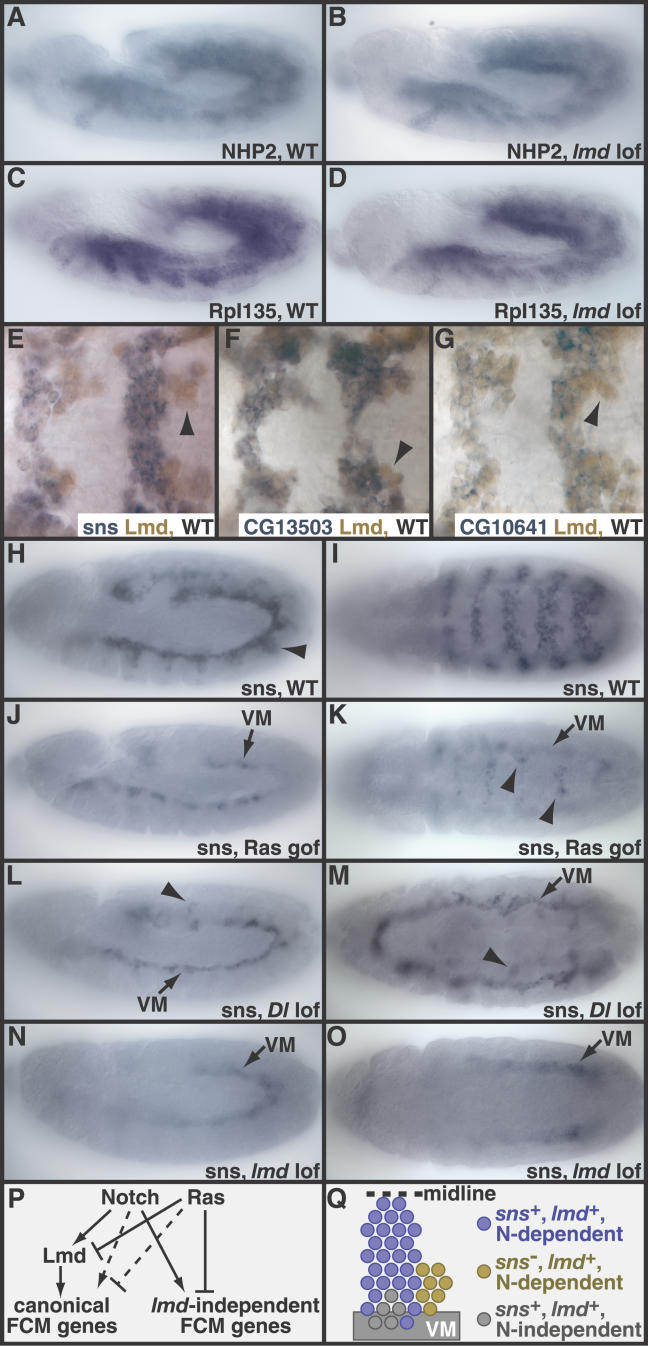
Heterogeneity in the Regulation of FCM Gene Expression(A–D) In situ hybridization of wild type and lmd mutant embryos with NHP2 (A and B) and RpI135 (C and D) gene probes shows that expression of these two FCM genes is independent of Lmd regulation.(E–G) Subset of ventral Lmd-expressing myoblasts (orange nuclei) without the expression of FCM markers such as sns, CG13503, and CG10641 (arrowheads in E, F, and G, respectively).(H–O) A subset of ventral myoblasts displays unexpected behavior. Wild-type expression of sns is observed in lateral (H) and ventral (I) somatic myoblasts (arrowhead in H). Lateral somatic myoblast expression is uniformly downregulated in Ras gof (J), Dl mutant (L), and lmd mutant (N) embryos, although visceral mesoderm (VM) expression is largely unchanged. A small ventral population of sns-expressing myoblasts remains in embryos with constitutive Ras activation (K, arrowheads) or loss of Dl (M), but expression in these cells is lost in lmd mutant embryos (O).(P) Expression of previously described (“canonical”) FCM-specific genes depends on Lmd, which is activated by Notch signaling and repressed by Ras signaling; a subset of FCM genes (A–D) are under the control of the Ras and Notch signaling pathways but do not require Lmd for their expression.(Q) The majority of somatic FCMs (blue) express sns and lmd and require Notch signaling for their specification; we have identified a subpopulation of cells (brown) that express lmd but not sns or other FCM markers (E–G) and additional cells (gray, including VM) that express sns even in the absence of the Notch ligand Dl.